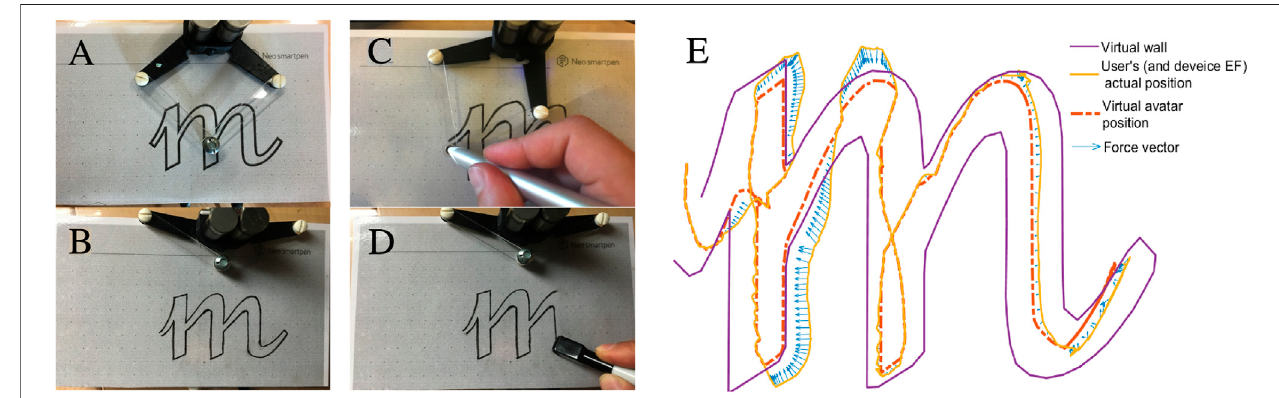
FIGURE 5 | A teacher prepares a handwriting activity by de fi ning a letter shape m ; the learner will then attempt to form the letter with assisting guidance. To create the m , the teacher can (A) laser-print a computer-generated graphic on paper, (B) draw it by hand, or (C) manually draw it with haptic assistance. For erasable media, e.g. , pencil on paper or marker on whiteboard, the teacher can (D) erase and draw a new exercise. (E) Exploring the m with ink marks rendered as virtual walls.